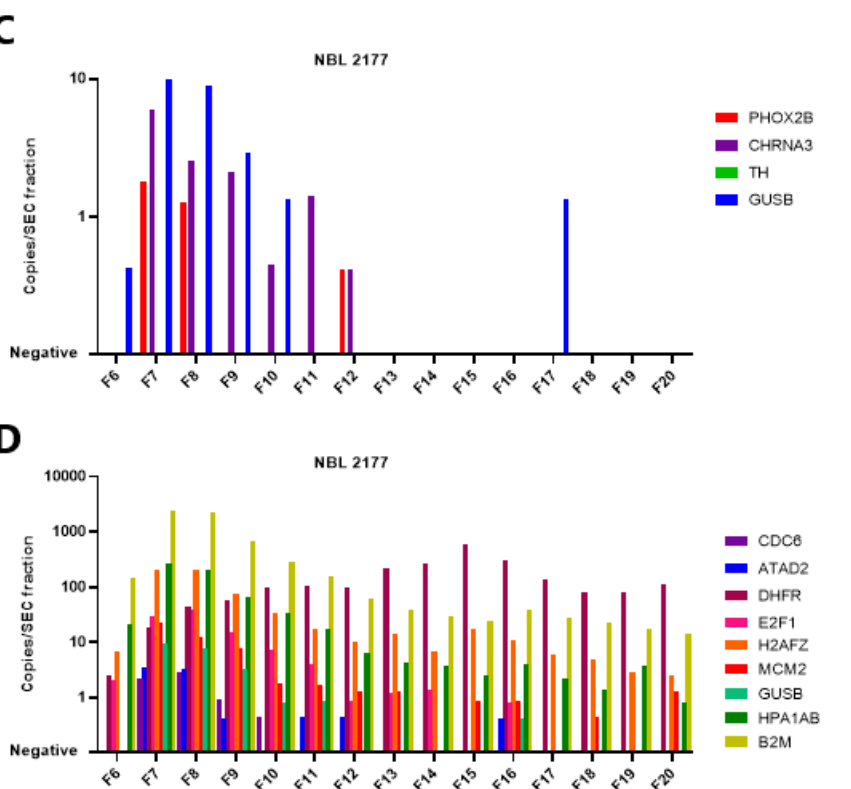
Figure 4. Expression of neuroblastoma-specific and cell cycle genes in 500 µ L of SEC (size exclusion chromatography) fractions, as isolated from 500 µ L plasma, from one healthy control and one patient with metastatic neuroblastoma. Fractions F7 to F10 are considered as enriched in extracellular vesicles (EV). In the healthy control, ( A ) shows the expression of the neuroblastoma-specific genes ( PHOX2B , CHRNA3 and TH with reference gene GUSB ) and ( B ) shows the expression of the cell cycle markers ( CDC6 , ATAD2 , DHFR , E2F1 , H2AFZ and MCM2 with GUSB , HPA1A/B and B2M ). In the patient NBL 2177, ( C ) shows the expression of the neuroblastoma-specific genes ( PHOX2B , CHRNA3 and TH with reference gene GUSB ) and ( D ) shows the expression of the cell cycle markers ( CDC6 , ATAD2 , DHFR , E2F1 , H2AFZ and MCM2 with GUSB , HPA1A/B and B2M ). Please note that the y -axis is represented on a log scale.